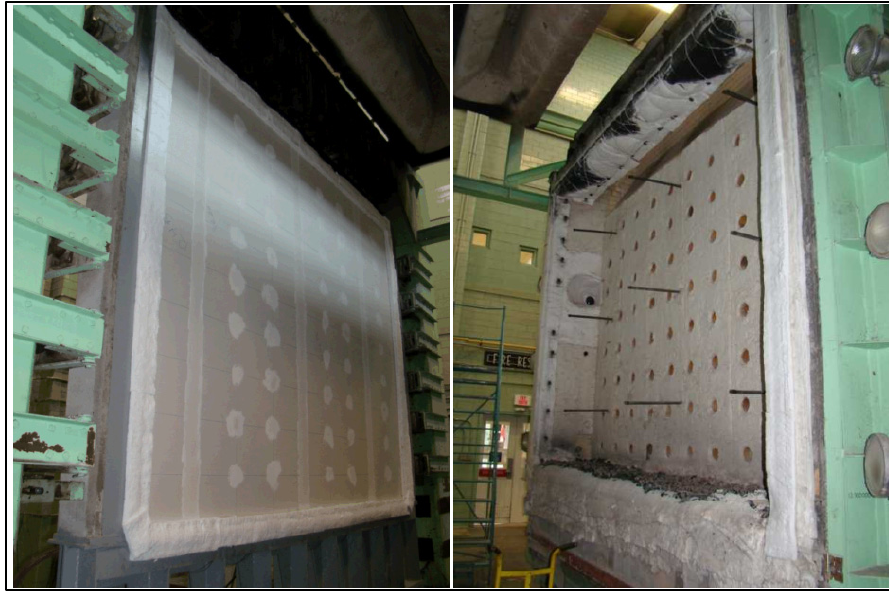
Figure 18. Wall furnace used for full ‐ scale fire ‐ resistance test.